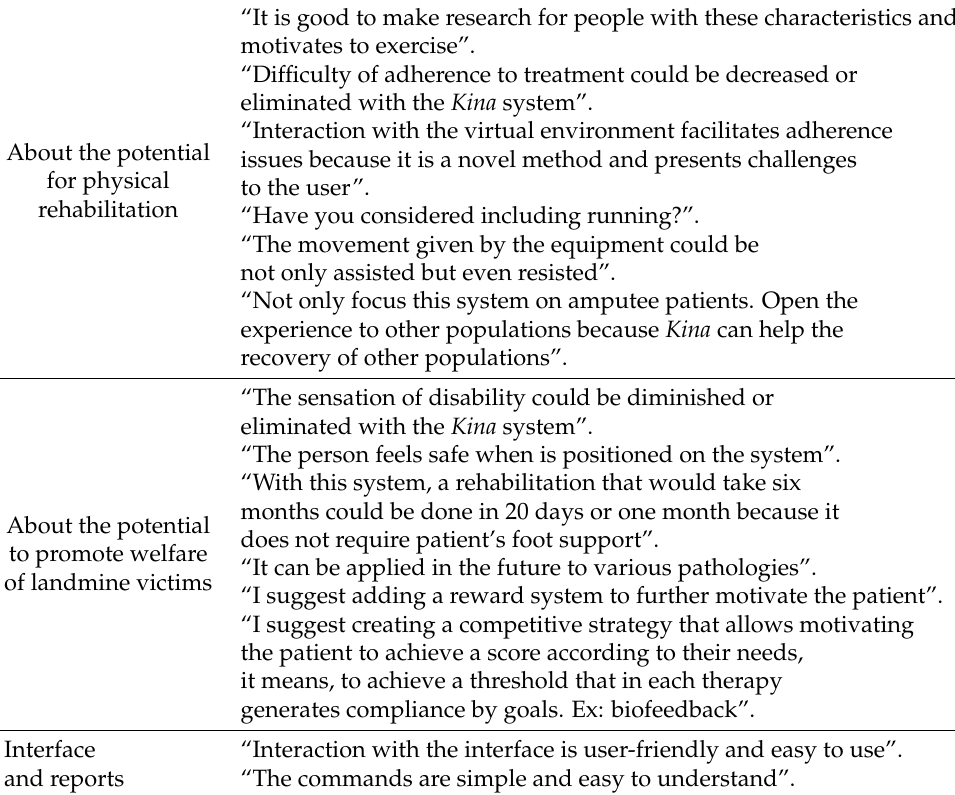
Table 12. Qualitative